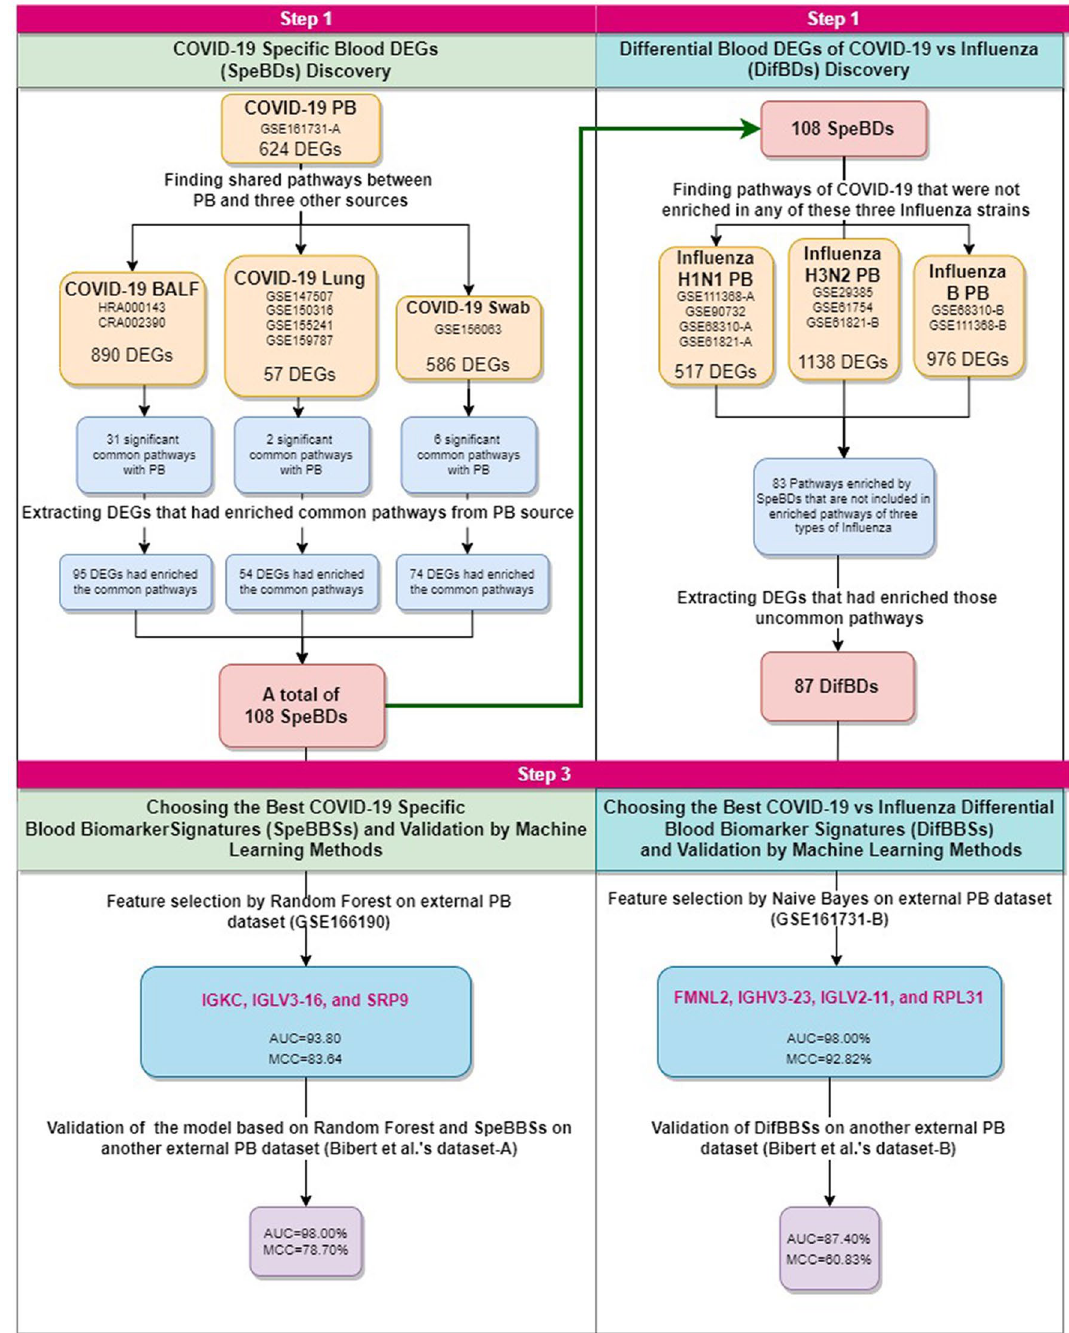
Figure 1. A workflow representing the main steps of the present study. Designed using diagram.net online tool available at https:// app. diagr ams.